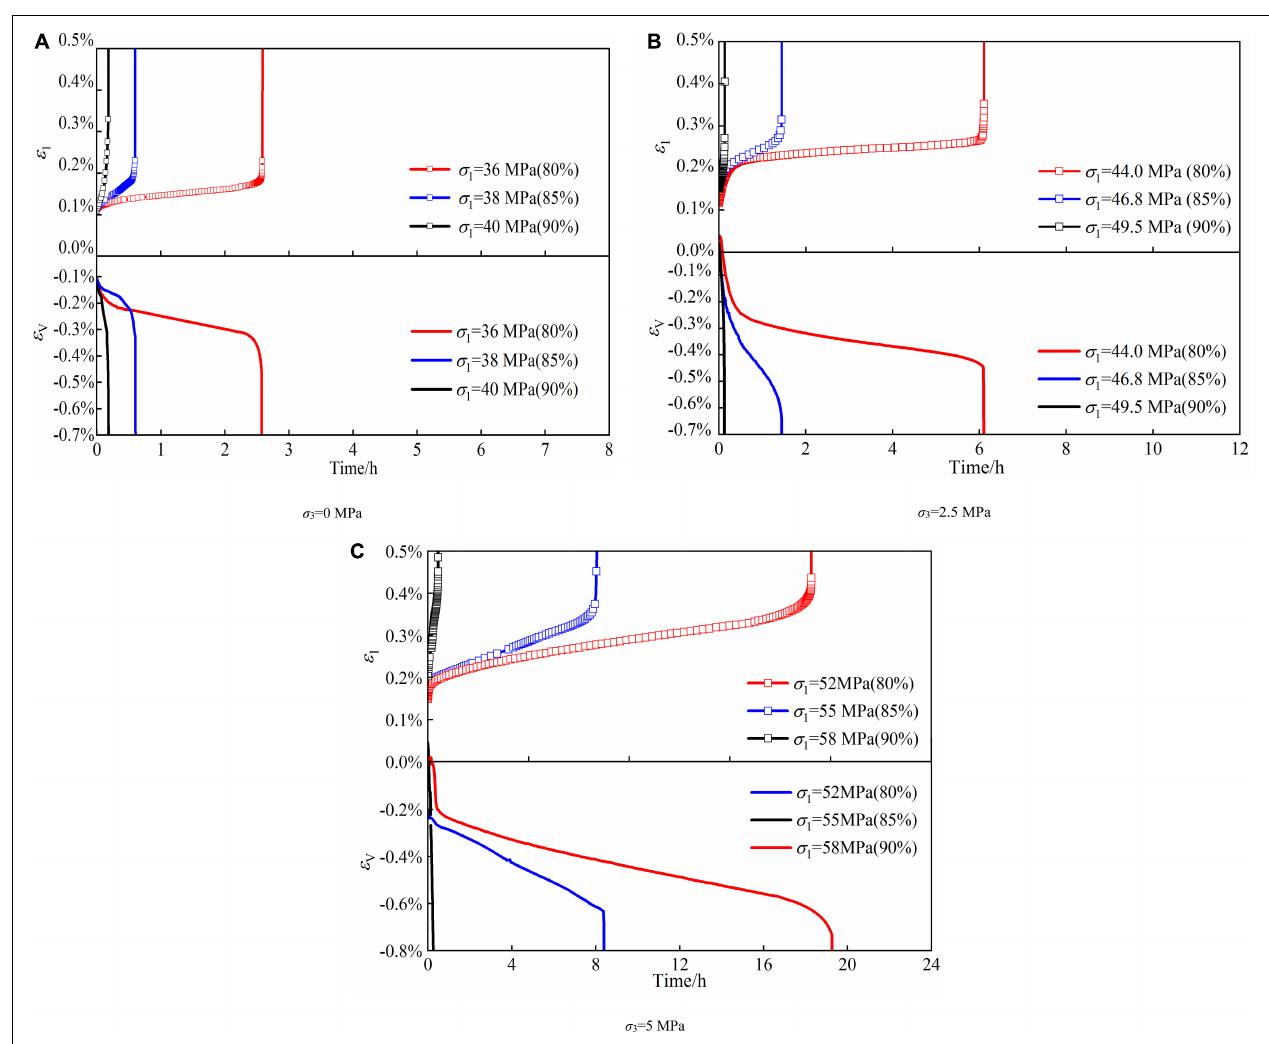
FIGURE 4 | Axial strain vs. time under various confining pressures. (A) σ 3 = 0 MPa. (B) σ 3 = 2.5 MPa. (C) σ 3 = 5 MPa.